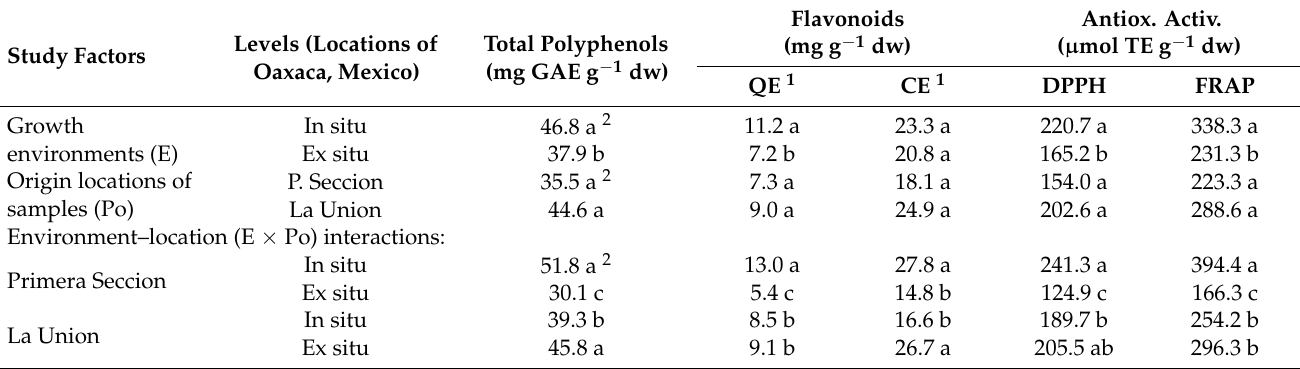
Table 3. Average content of phenolic compounds and antioxidant activity of A. petiolaris plants sampled in situ (natural conditions) and cultivated ex situ at Oaxaca,